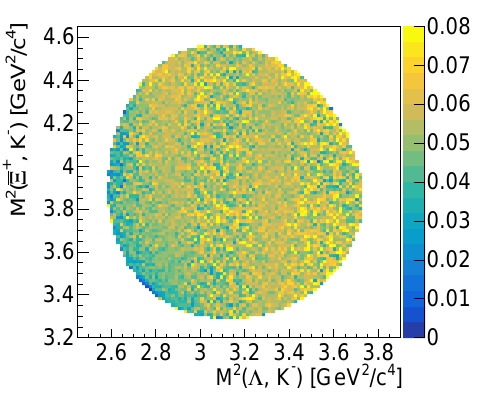
Figure 4. Ratio of the MC truth partner of the final selected and the generated sample. Adapted from [12]